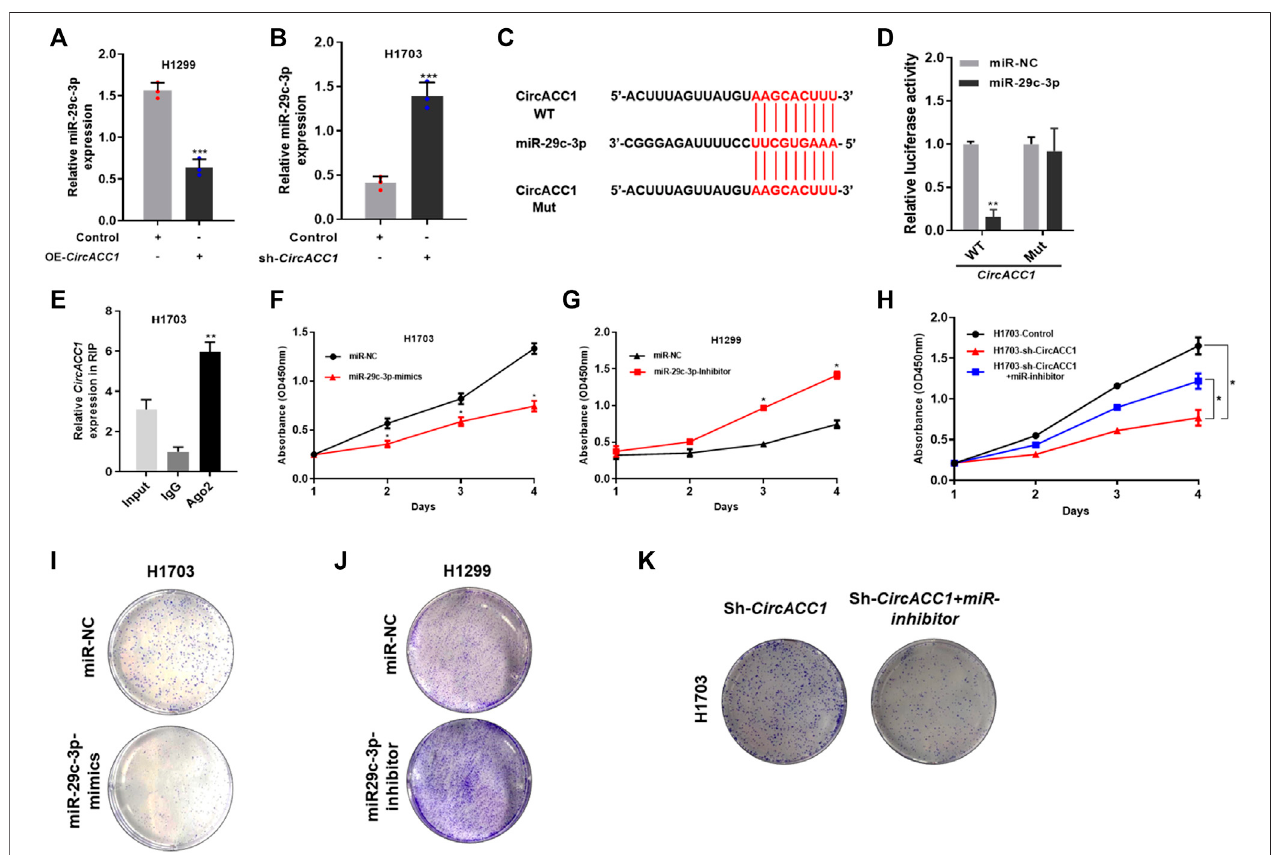
FIGURE 3 | miR-29c-3p is a key binding target of circACC1 in NSCLC cells. (A,B) . The expression of miR-29c-3p in LV-H1299-circACC1 and LV- H1703- shcircACC1 cell lines by RT-qPCR. Data are mean ± SD, *** p < 0.001; (C,D) . The luciferase activity of Luc-circACC1-wt or Luc-circACC1-mutant in NSCLC cells co- transfectedwithmiR-29c-3pmimics.Dataaremean ± SD.** p < 0.01; (E) .RIPassayforthedegreeofmiR-29c-3pwithcircACC1probe.Dataaremean ± SD.** p < 0.01; (F – H) . The effect of miR-29c-3p on cell viability by CCK-8 assay. Data are mean ± SD. * p < 0.05; (I,K) . The effect of miR-29c-3p on cell viability by colony formation